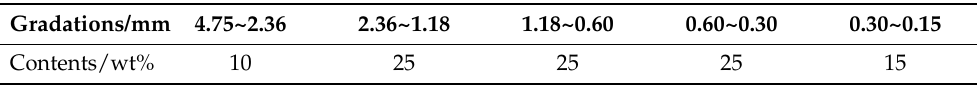
Table 3. Gradations and percentage contents of the four types of quartz sand